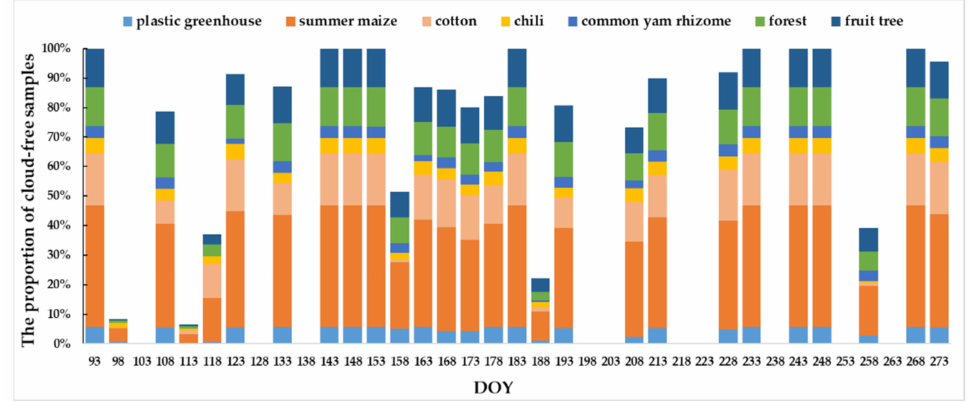
Figure 5. Proportions of cloud-free samples.